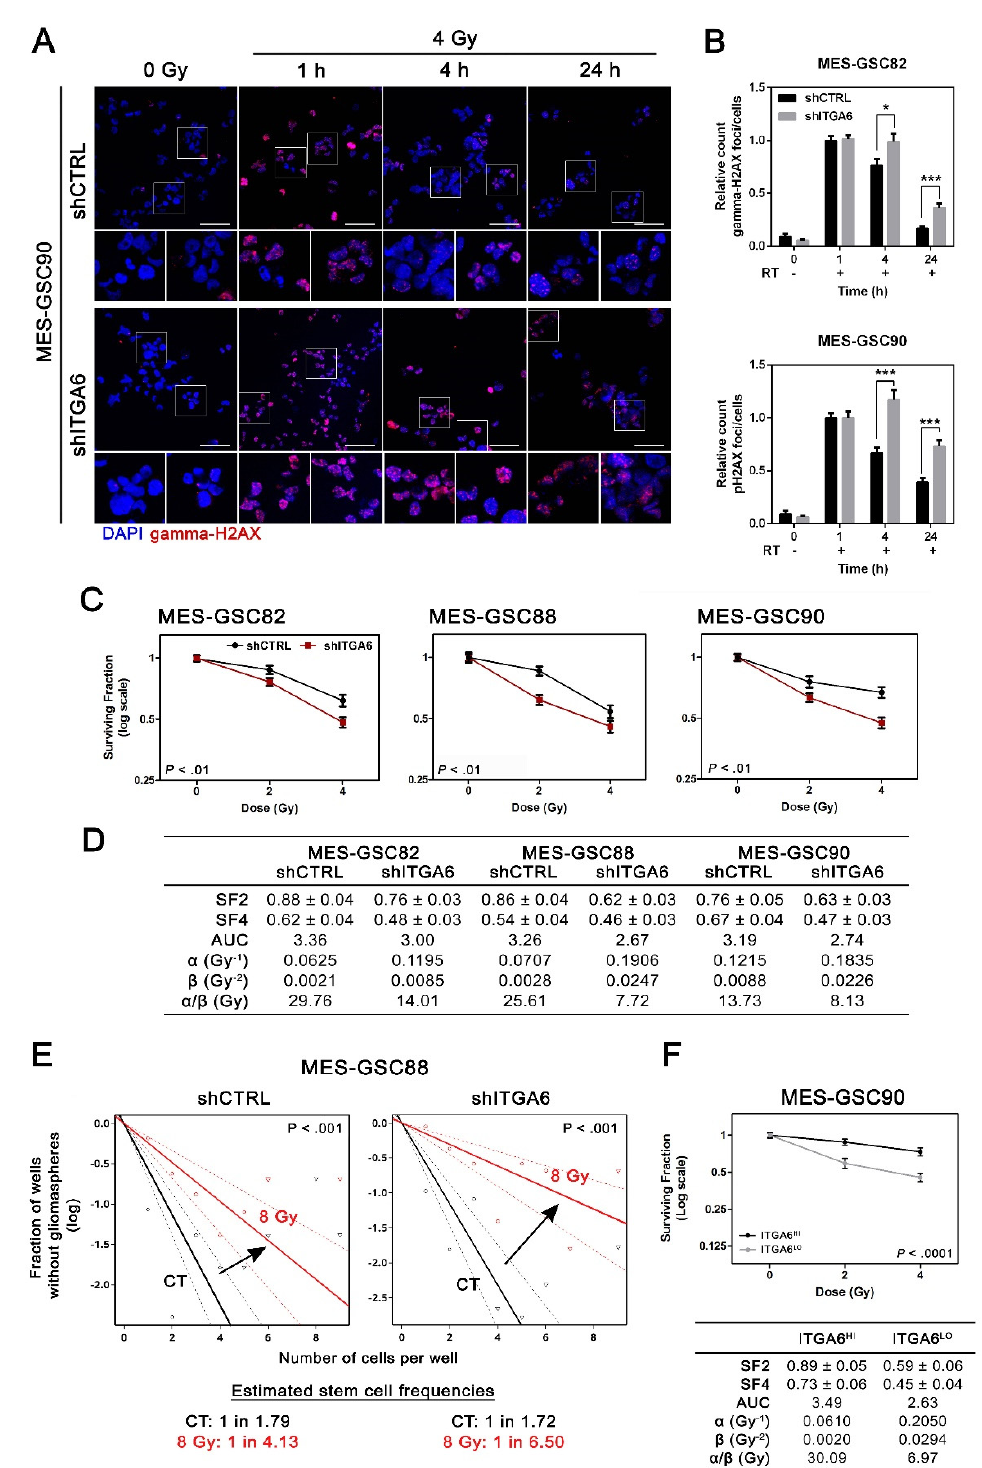
Figure 4. Inhibition of integrin a6 expression in MES-GSCs triggers radiosensitivity. ( A , B ) Gamma-H2AX foci decay after IR-induced DNA damage. ( A ) Representative microsections of the gamma-H2AX foci detected in MES-GSC90 by immunofluorescence (scale bar = 50 µ m). Gamma-H2AX foci were stained in red, while nuclei were counterstained with DRAQ5. Smaller frames display the same sections at higher magnification. ( B ) Absolute quantitation of gamma-H2AX foci after a single fraction of 4 Gy (mean ± SEM; n = 3; unpaired t-test). A minimum of 10 fields per condition reaching a minimum of 70 cells in total were analysed ( n = 3). ( C ) Survival curves of MES-GSCs obtained for control (shCTRL) and ITGA6 -inhibited cultures (shITGA6) following RT ( n = 4). Two-way ANOVA reported within each plot. ( D ) Linear